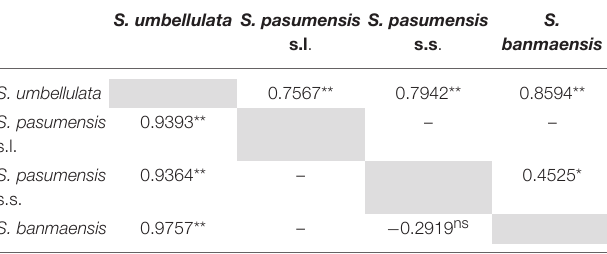
TABLE 4 | Pairwise comparisons of F ST between populations of Saxifraga banmaensis , S. pasumensis s.s. and S. umbellulata , and between populations of S. pasumensis s.l. and S. umbellulata , based on cpDNA (lower triangle) and ITS (upper triangle) datasets,